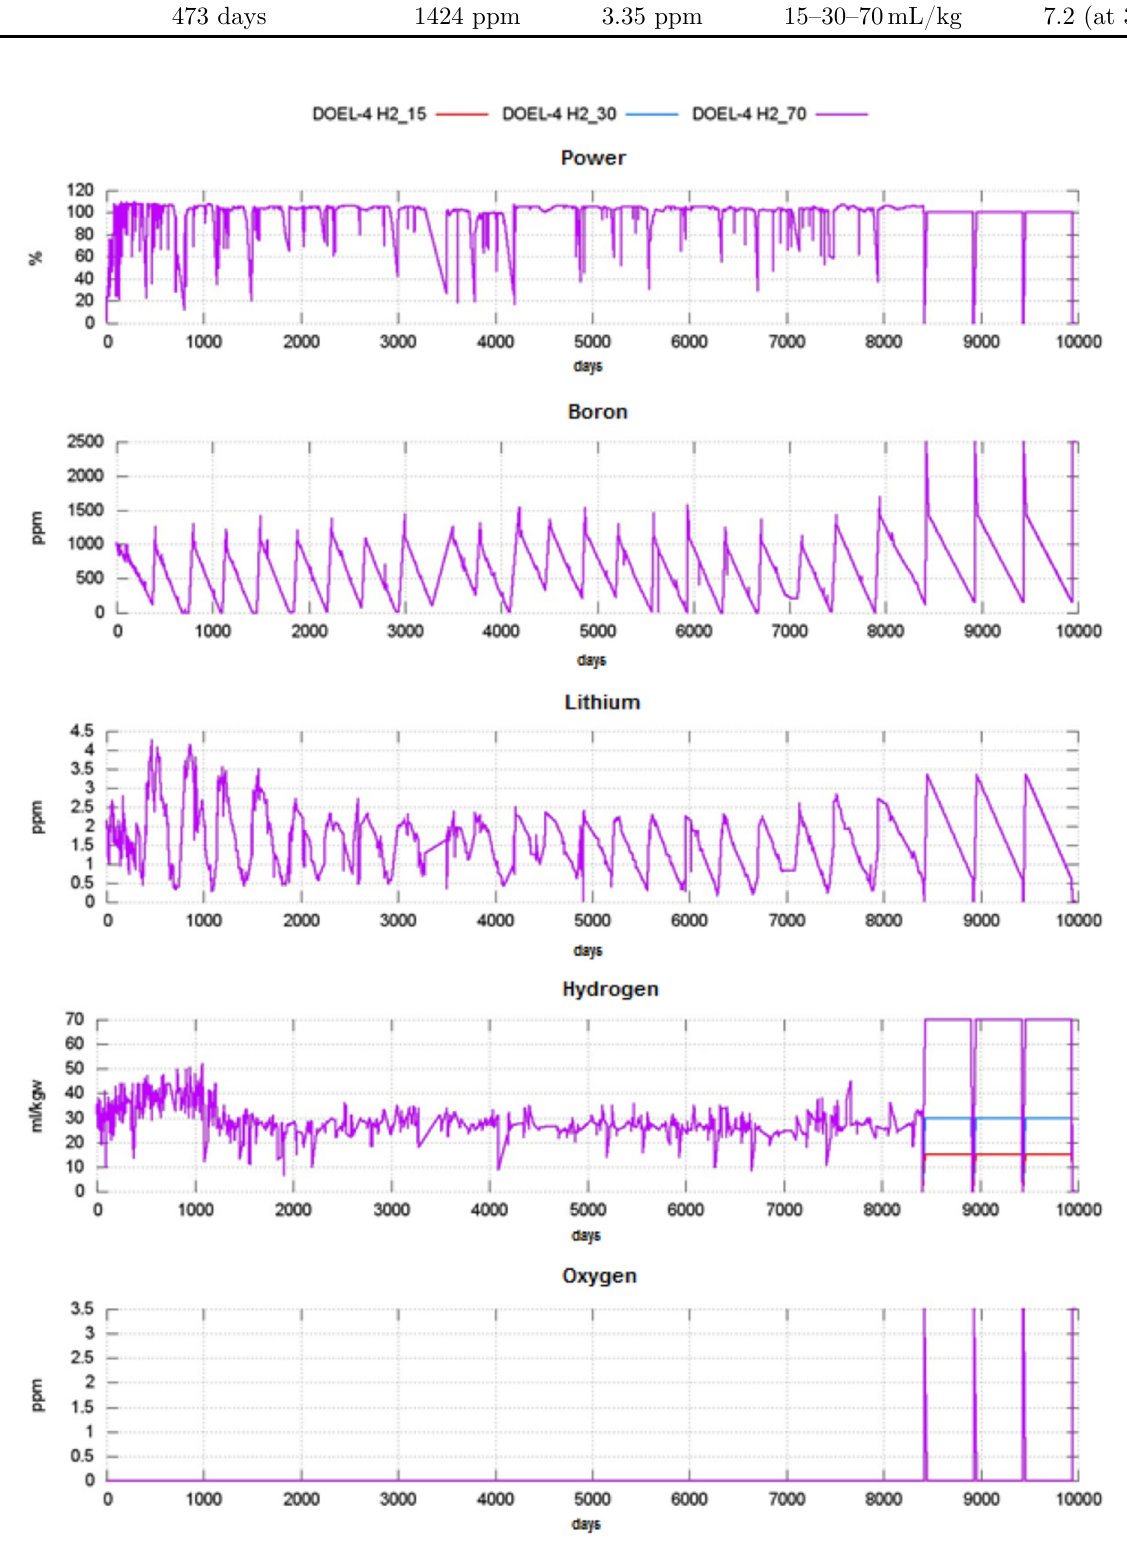
Fig. 3. DOEL-4 operating